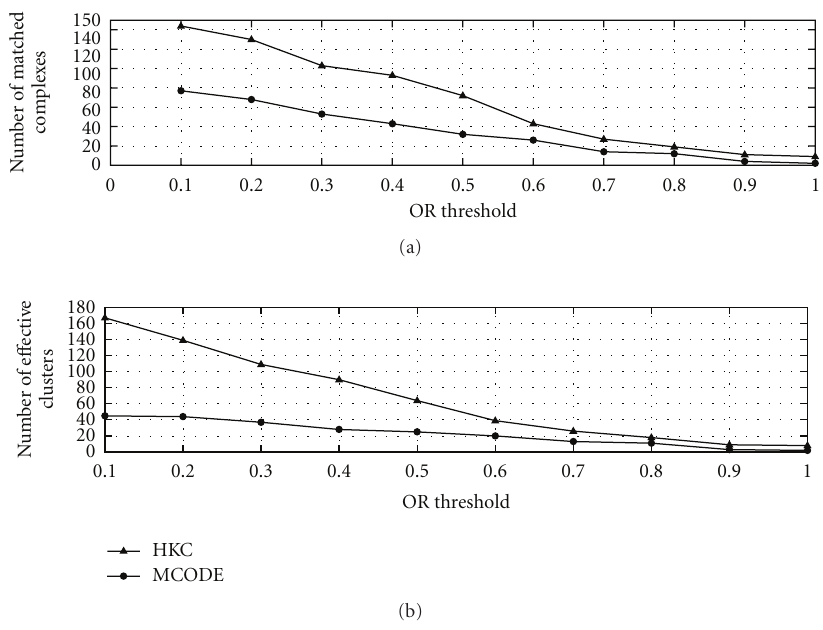
Figure 4: The number of e ff ective clusters and the number of matched complexes by HKC and MCODE with respect to di ff erent OR thresholds. The result is corresponding to MIPS data set and evaluated on complexcat benchmark. Triangles mark the results of HKC and circles mark the results of